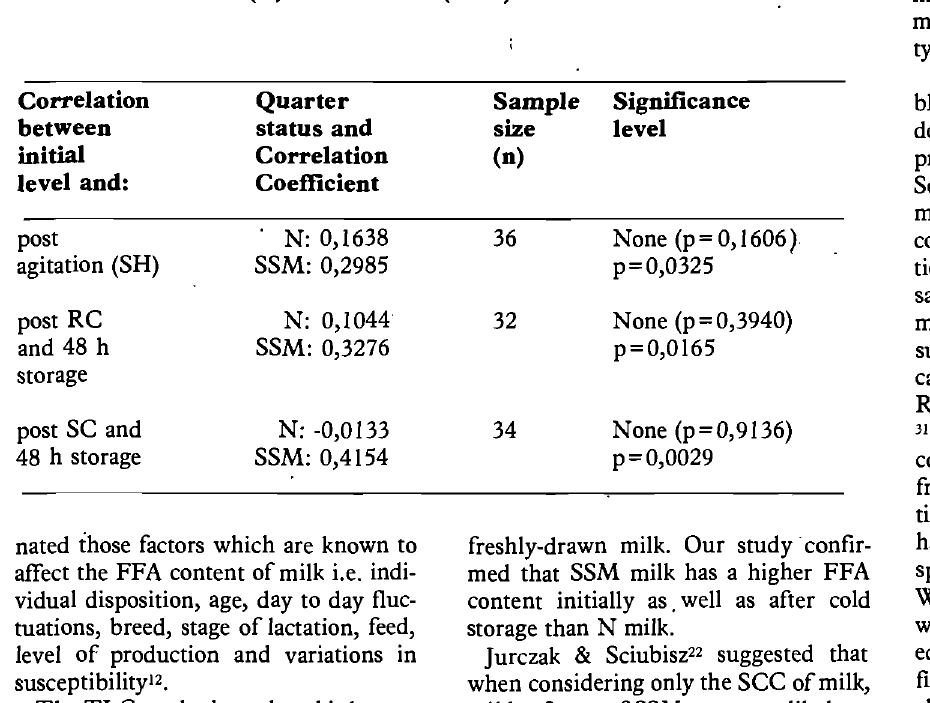
Table I: Correlation between the initial and post-treatment FFA content of normal (N) and mastitic (SSM)